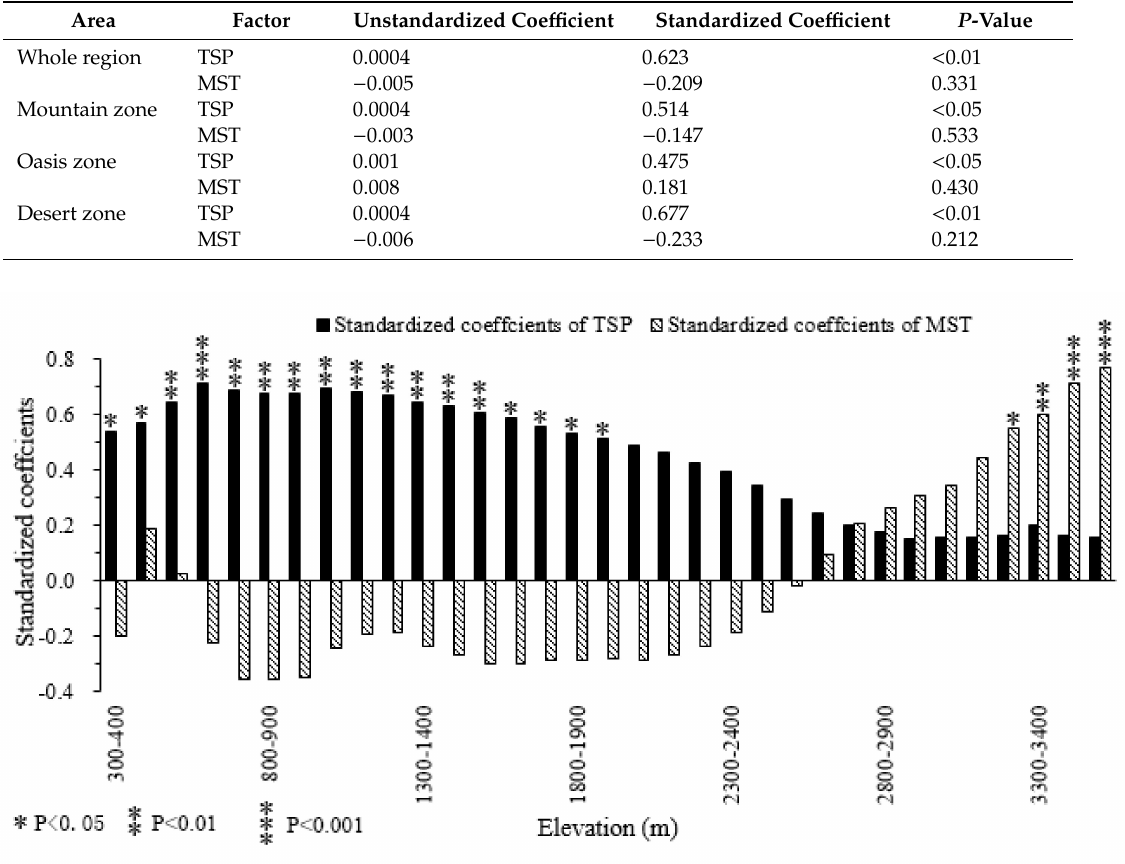
Table 1. Standardized regression coe ffi cients between NDVI and total summer precipitation, mean